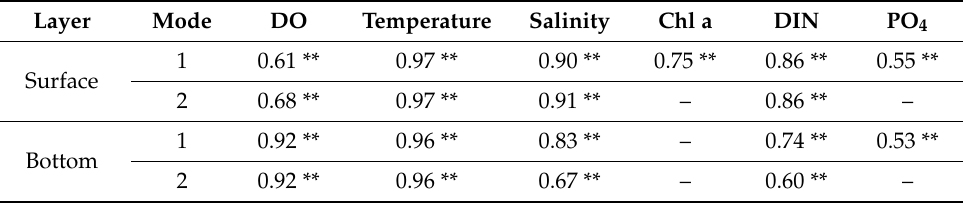
Table 4. Correlation coe ffi cients between RPCs and the fitted